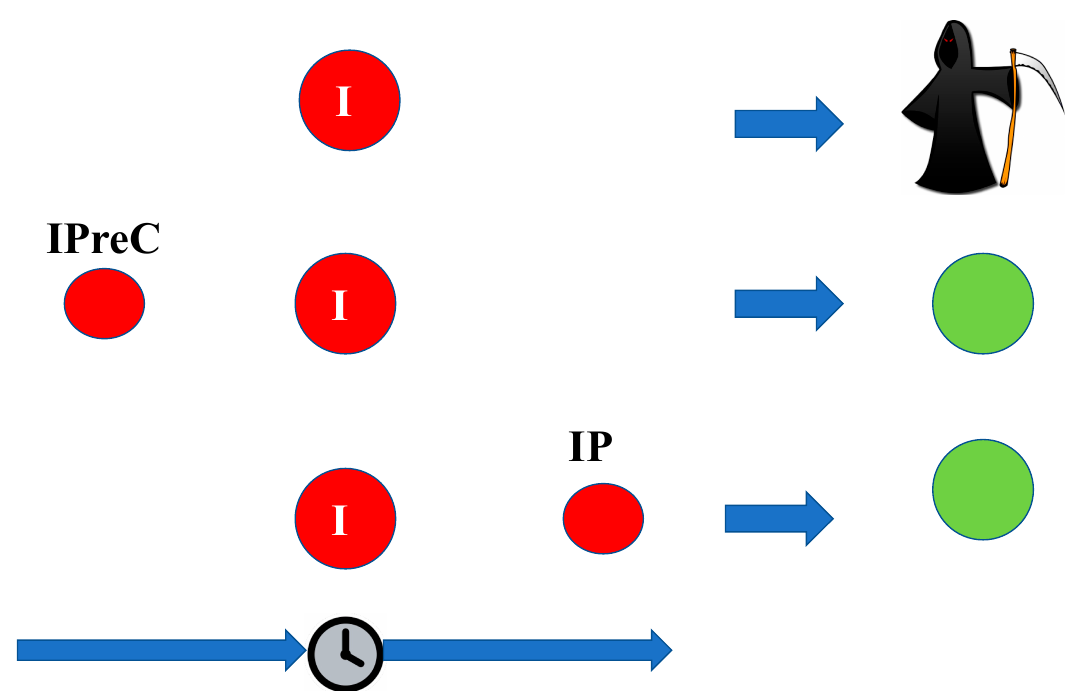
Figure 2. A schematic representation of the different ways of initiating ischemic tolerance. According to the time in which the sublethal ischemia acts relative to the lethal ischemia, we can distinguish the following mechanisms that lead to the initiation of ischemic tolerance. I—ischemic damage, IPreC—ischemic preconditioning, IP—ischemic postconditioning.